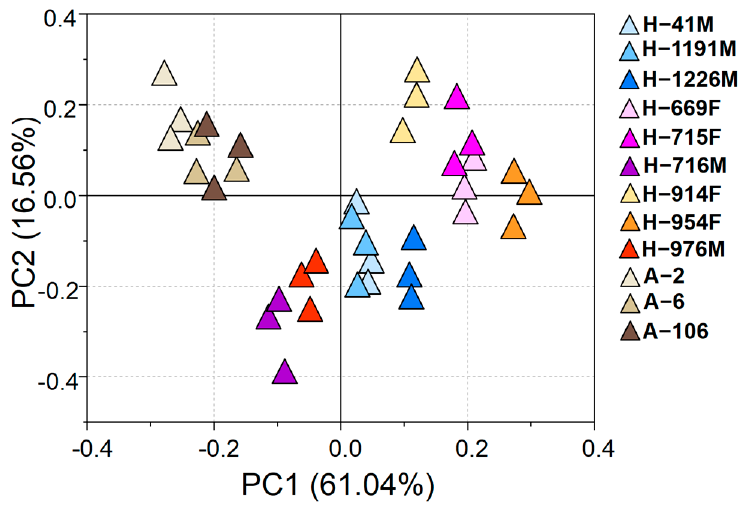
Figure 3. PCA scores plot of bones’ spectral parameters; the percentages of variance explained by PC1 and PC2 are reported in